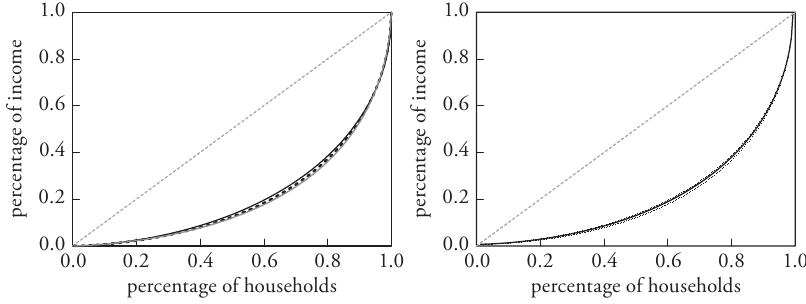
Figure 4: Estimates of the Lorenz curve and the 99 % point-wise confidence